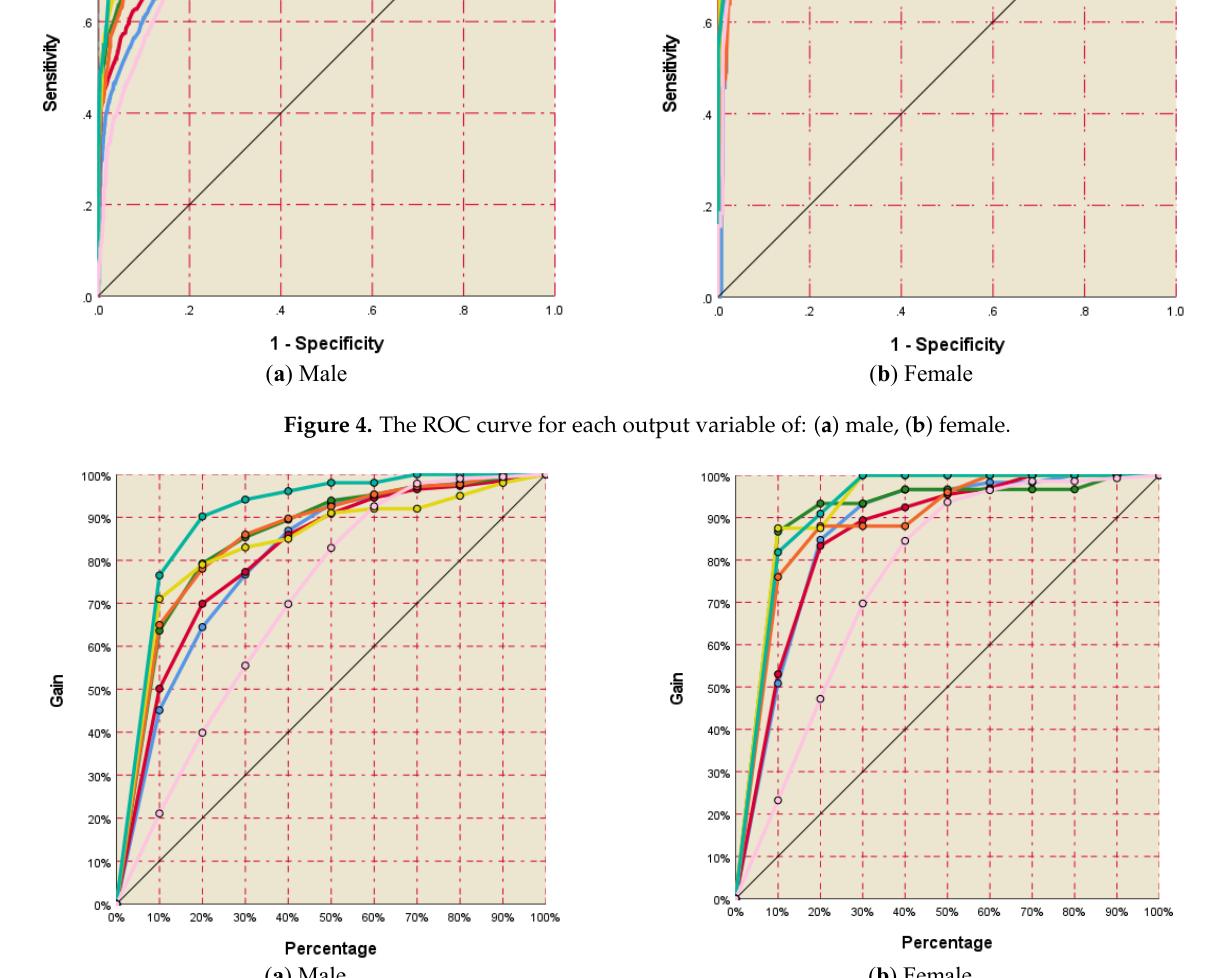
Figure 4. The ROC curve for each output variable of: ( a ) male, ( b ) female.